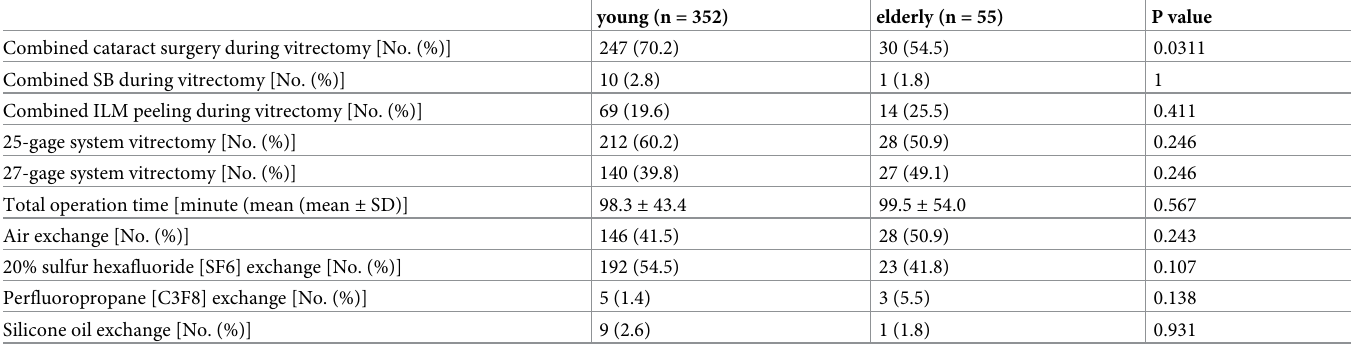
Table 3. Characteristics of the surgical procedure in the young and elderly